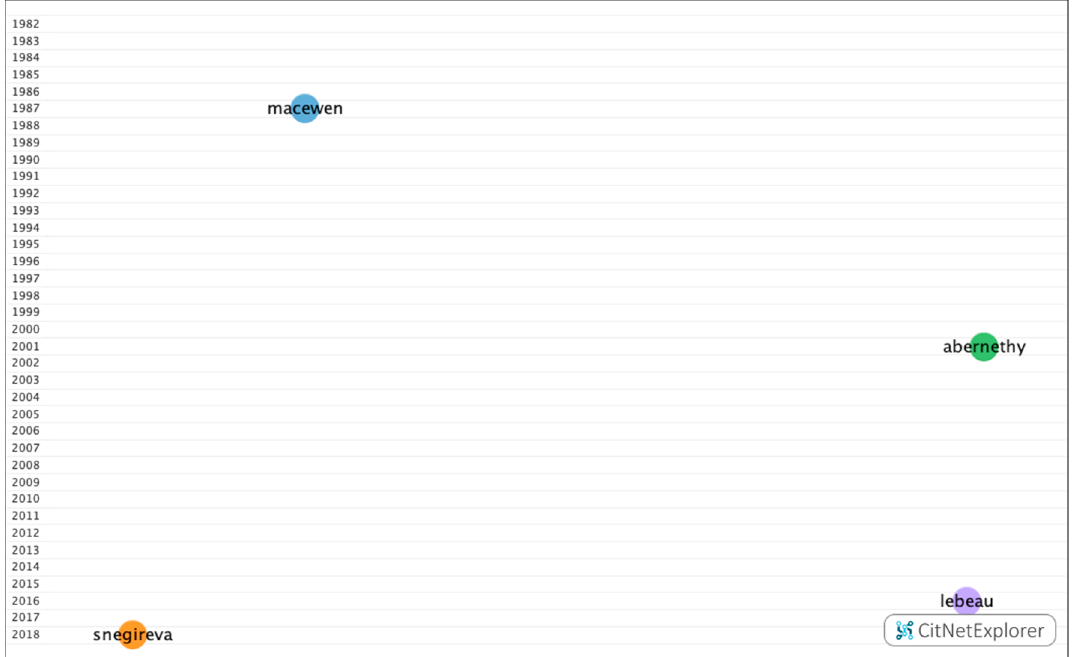
Figure 8. Connection between the four main groups.